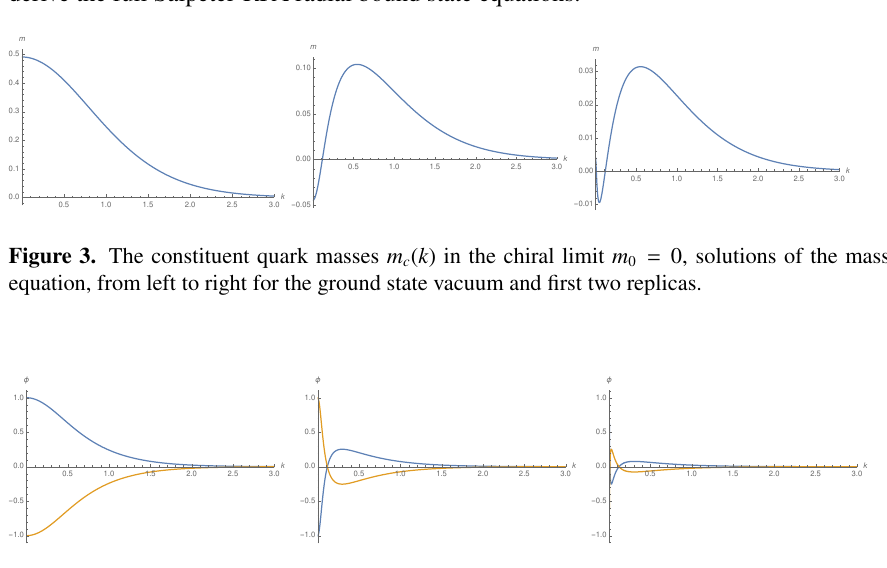
Figure 4. The J PC = 0 − + , 1 S 0 normalized pseudoscalar (P) radial wave functions φ + (in blue) and φ − (in yellow), from left to right for the ground state vacuum and first two replicas, in dimensionless in units of K 0 = 1. Because the normalization diverges in the chiral limit, we arbitrarily normalize the wave functions with φ (0) = 1. Importantly, the wavefunctions φ ± are identical to ± sin ϕ ( k ) = √ k ) / k + m k ) as is easily verified from Fig. ± m c ( c (